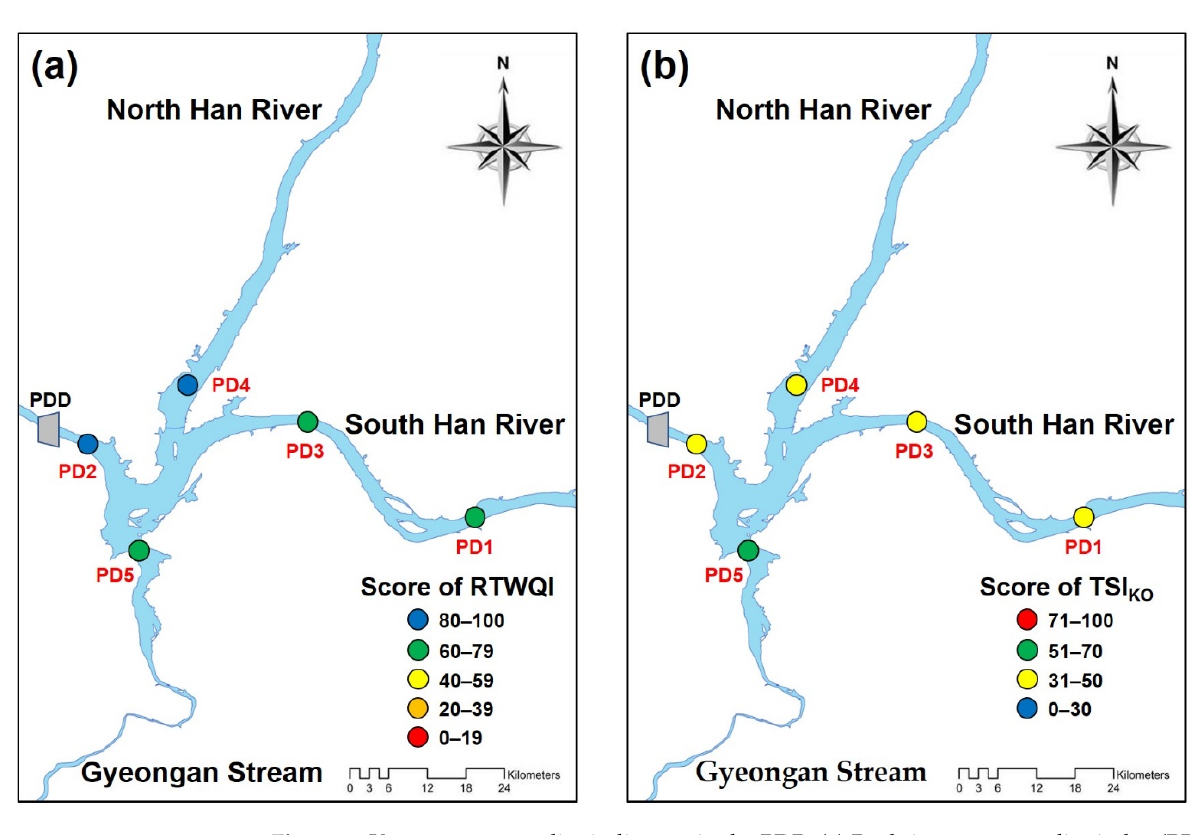
Figure 3. Korean water quality indicators in the PDR. ( a ) Real-time water quality index (RTWQI); ( b ) Korean trophic state index (TSI KO ).